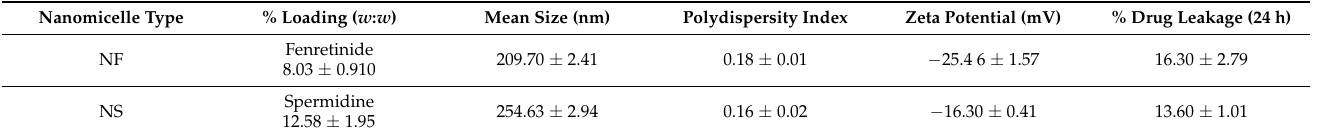
Table 1. Physicochemical characteristics of Nanofenretinide (NF) and Nanospermidine (NS) in PBS at 0.05 mg/mL.